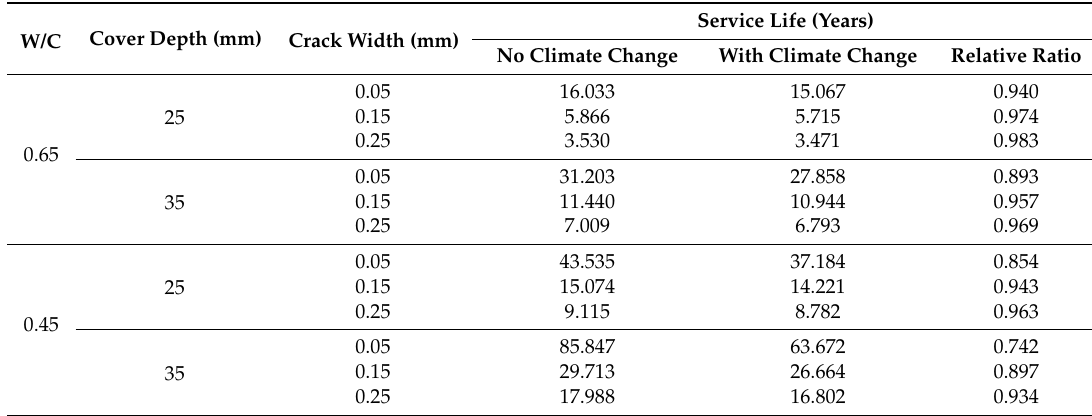
Table 4. Service life of cracked concrete-RCP 8.5, time slice 2000.